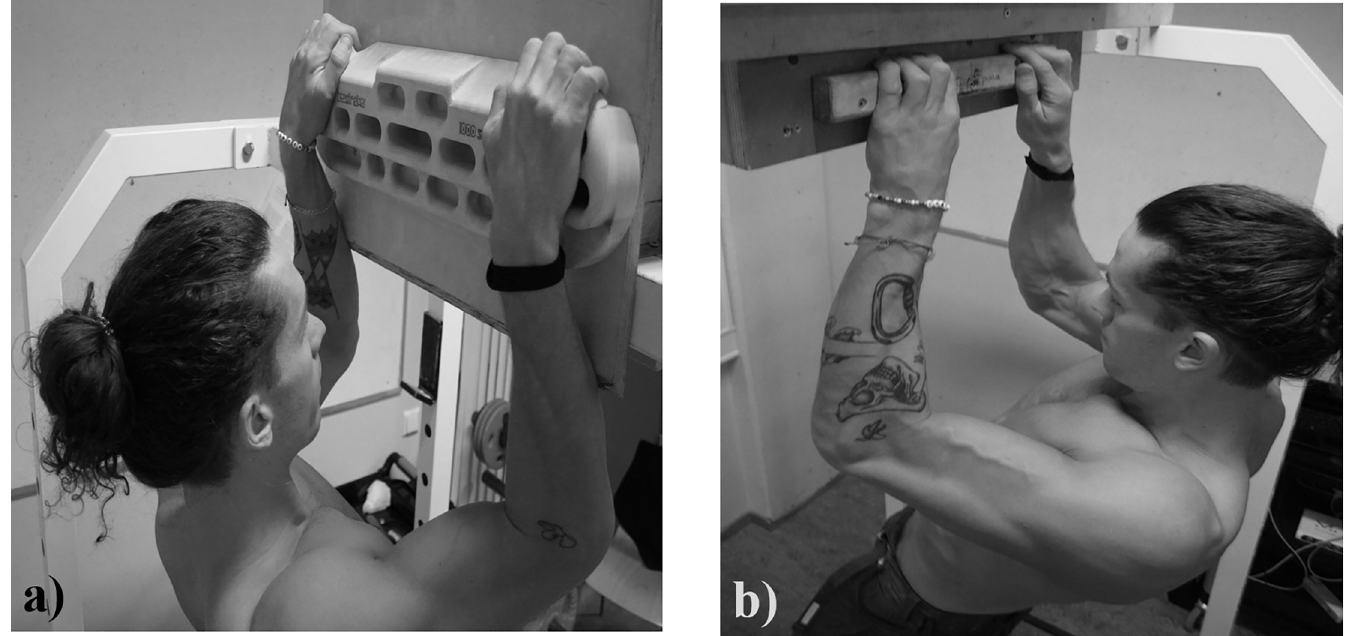
Fig 3. The isometric pull-up using the jug (a) and ledge